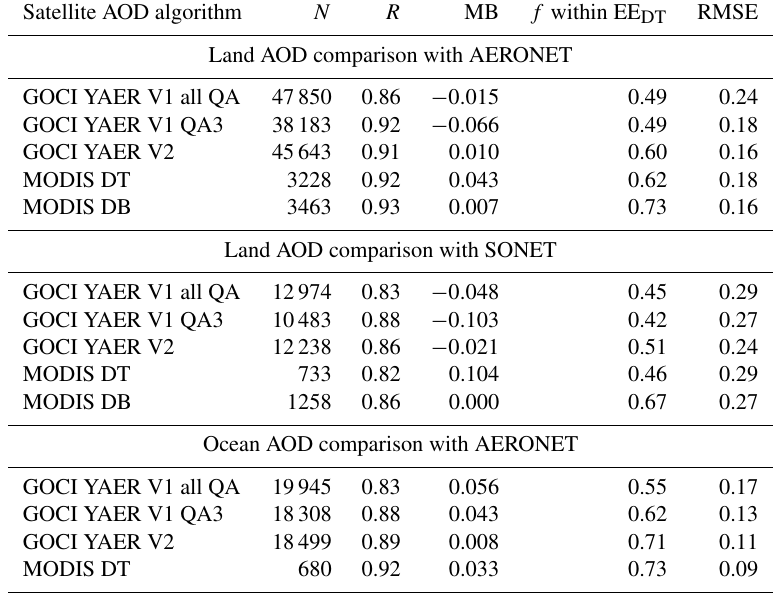
Figure 3. Comparison of AOD between AERONET/SONET and GOCI/MODIS DT/MODIS DB over land and ocean surfaces. The x axis is land AERONET AOD, land SONET AOD, and ocean AERONET AOD from top to bottom, and the y axis is GOCI YAER V1 for all QA, GOCI YAER V1 for QA = 3, GOCI YAER V2, MODIS DT, and MODIS DB from left to right. Colored pixels represent a bin size of 0.02. Black dashed lines denote the one-to-one line, and dotted lines denote the expected error range of MODIS DT AOD. Table 2. Statistics of land and ocean AOD comparisons between AERONET/SONET and satellite products, as shown in Fig. 3. Satellite AOD algorithm N R MB f within EE DT